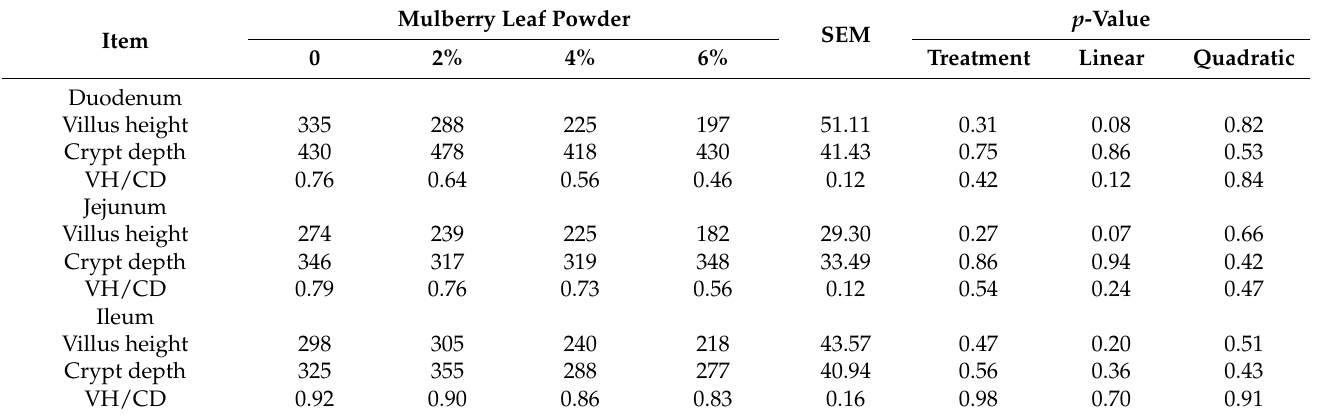
Figure 2. Digestive enzyme activity ( A ) and intestinal inflammatory factors ( B ) in finishing pigs dietary supplementation of mulberry leaf powder of varying levels. IL-1 β , interleukin-1 β ; IL-4, interleukin-4; IL-6, interleukin-6; IL-10 interleukin-10; TNF- α , tumor necrosis factor- α ; sIgA, secretory immunoglobulin A. Ctrl, basal diet with 0% MP; MP_6, MP_9 and MP_12 are the batabksal diets supplemented with 6%, 9% and 12% MP, respectively. Data were displayed as mean ± SEM. Bar with different asterisk (*) indicated the degree of significant difference. n = 3. *, p < 0.05. Table 8. Effect of mulberry leaf powder of varying levels on intestinal morphology in finishing